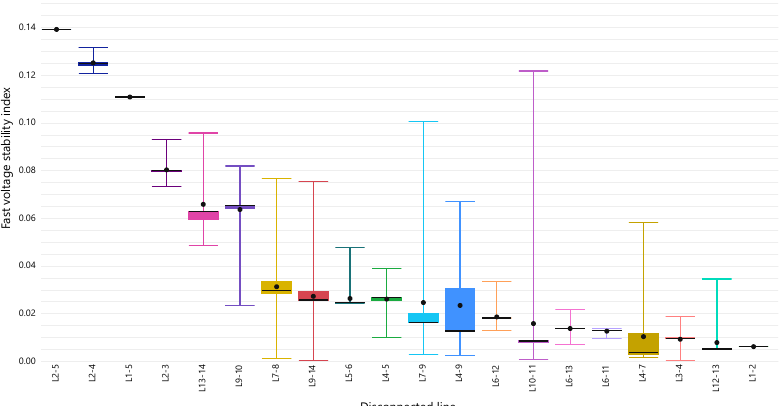
Figure 4. Fourteen-bus-bar system: FVSIs for every contingency scenario with optimal compensation. Power BI Desktop